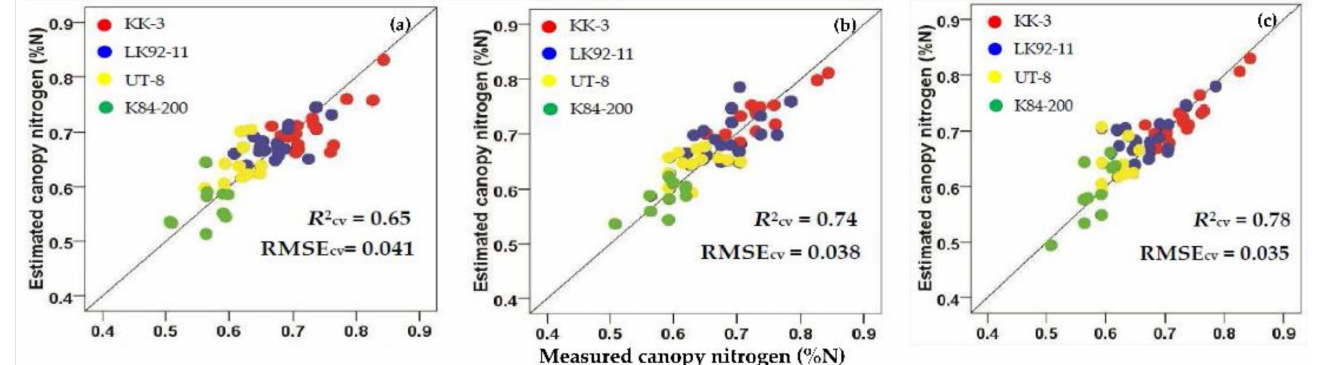
Figure 23. Measured vs. estimated canopy nitrogen contents (%N) for different sugarcane varieties (adopted from Miphokasap and Wannasiri [127]). ( a ) First derivative spectrum (FDS), ( b ) continuum-removed derivative reflectance (CRDR), and ( c ) band depth (BD) were used to calibrate three prediction models using the SVR method.